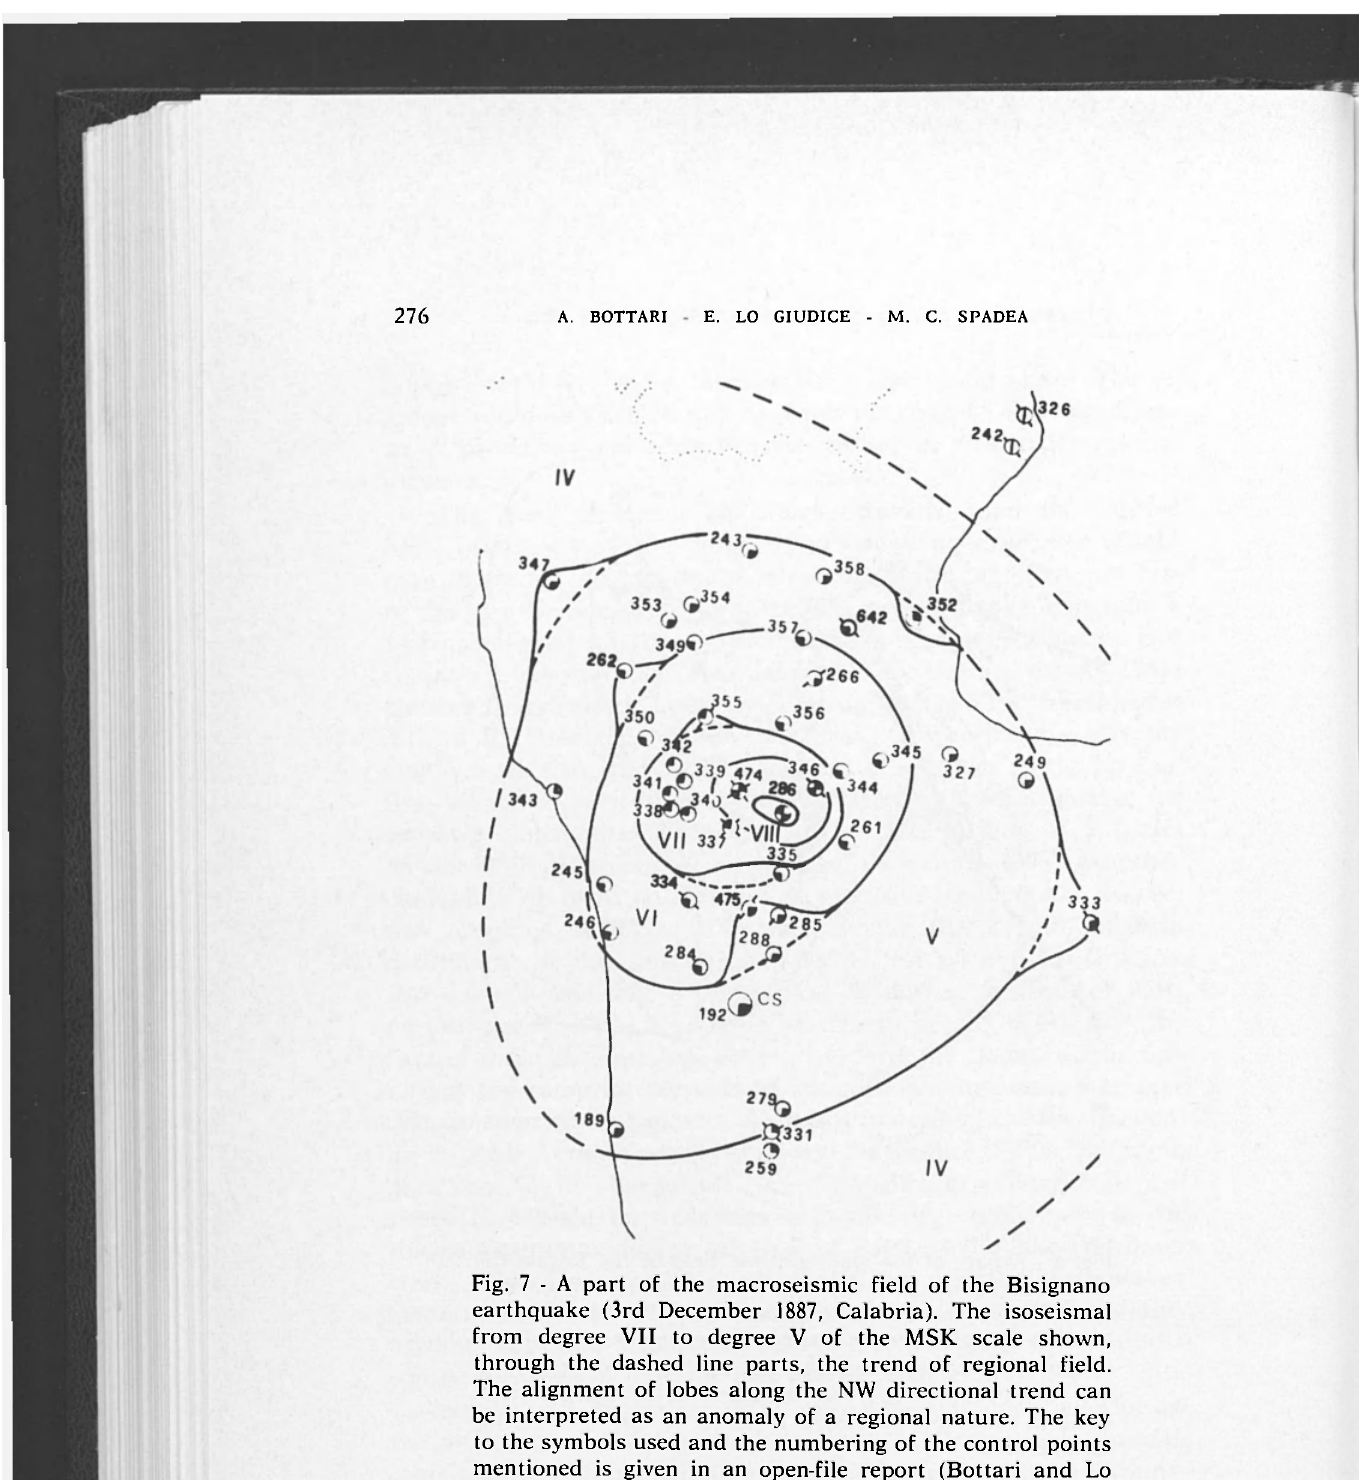
Fig. 7 - A part of the macroseismic field of the Bisignano earthquake (3rd December 1887, Calabria). The isoseismal from degree VII to degree V of the MSK scale shown, through the dashed line parts, the trend of regional field. The alignment of lobes along the NW directional trend can be interpreted as an anomaly of a regional nature. The key to the symbols used and the numbering of the control points mentioned is given in an open-file report (Bottari and Lo Giudice, in